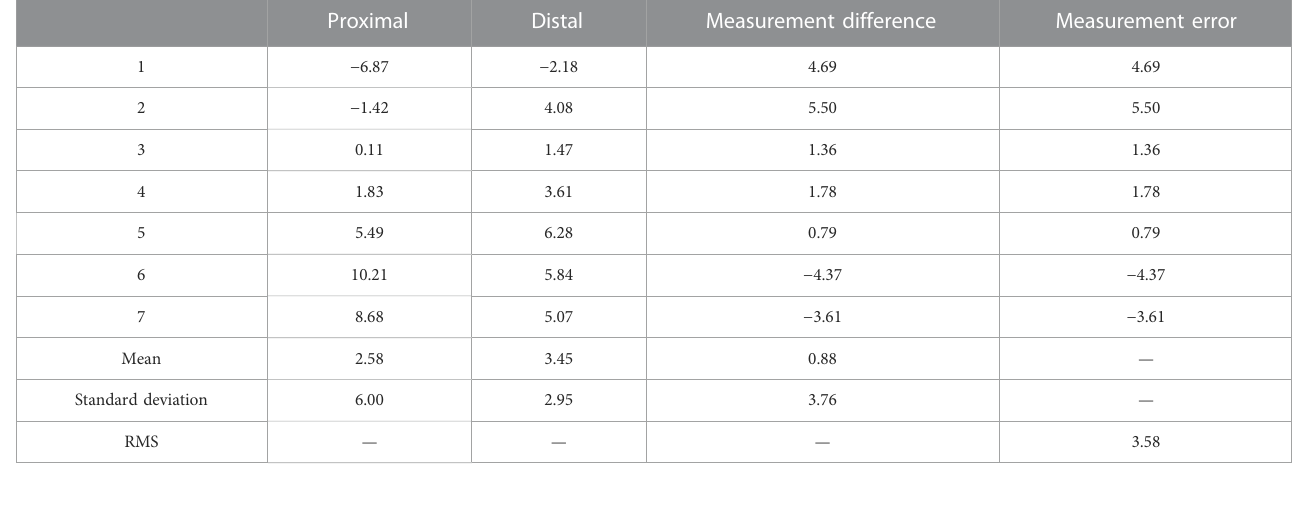
TABLE 2 Statistics of static accuracy test data of GGMS( T xy ).